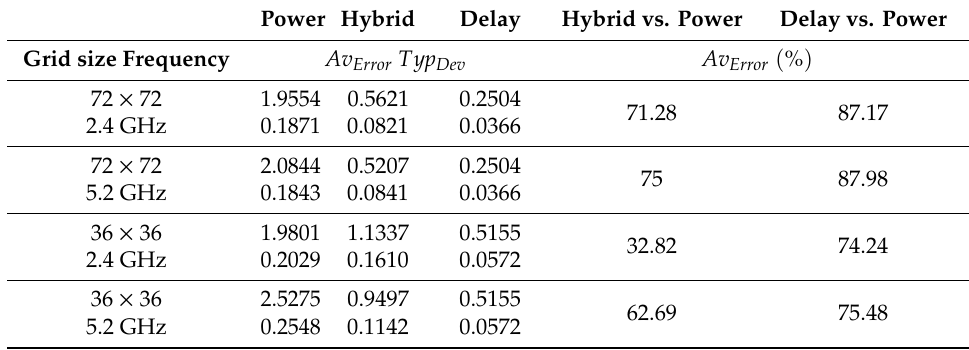
Table 3. Indoor simulations results: Localization error when comparing the detection methods.